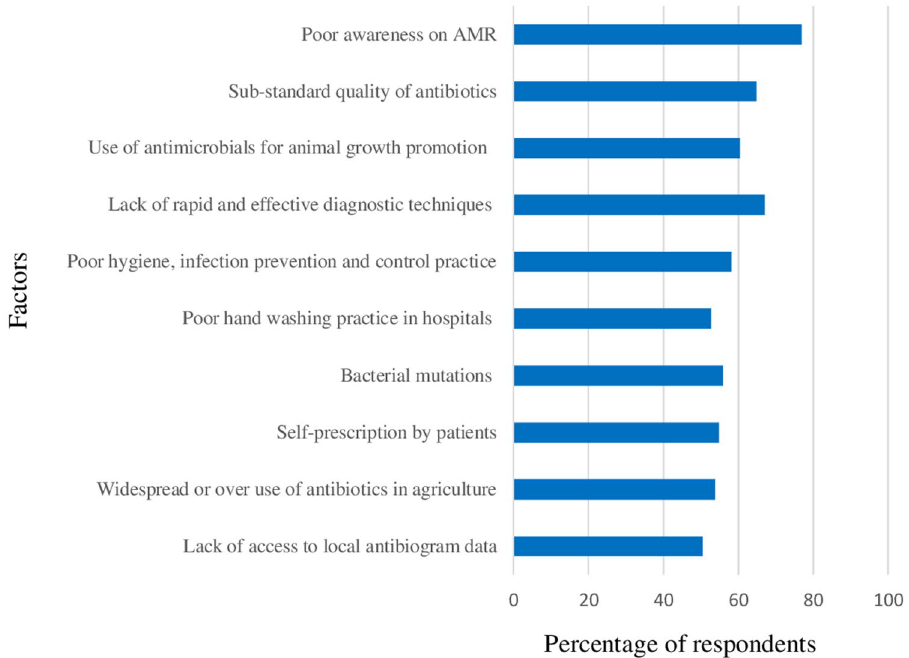
Figure 6. Factors that contribute to increase antibiotic resistance.